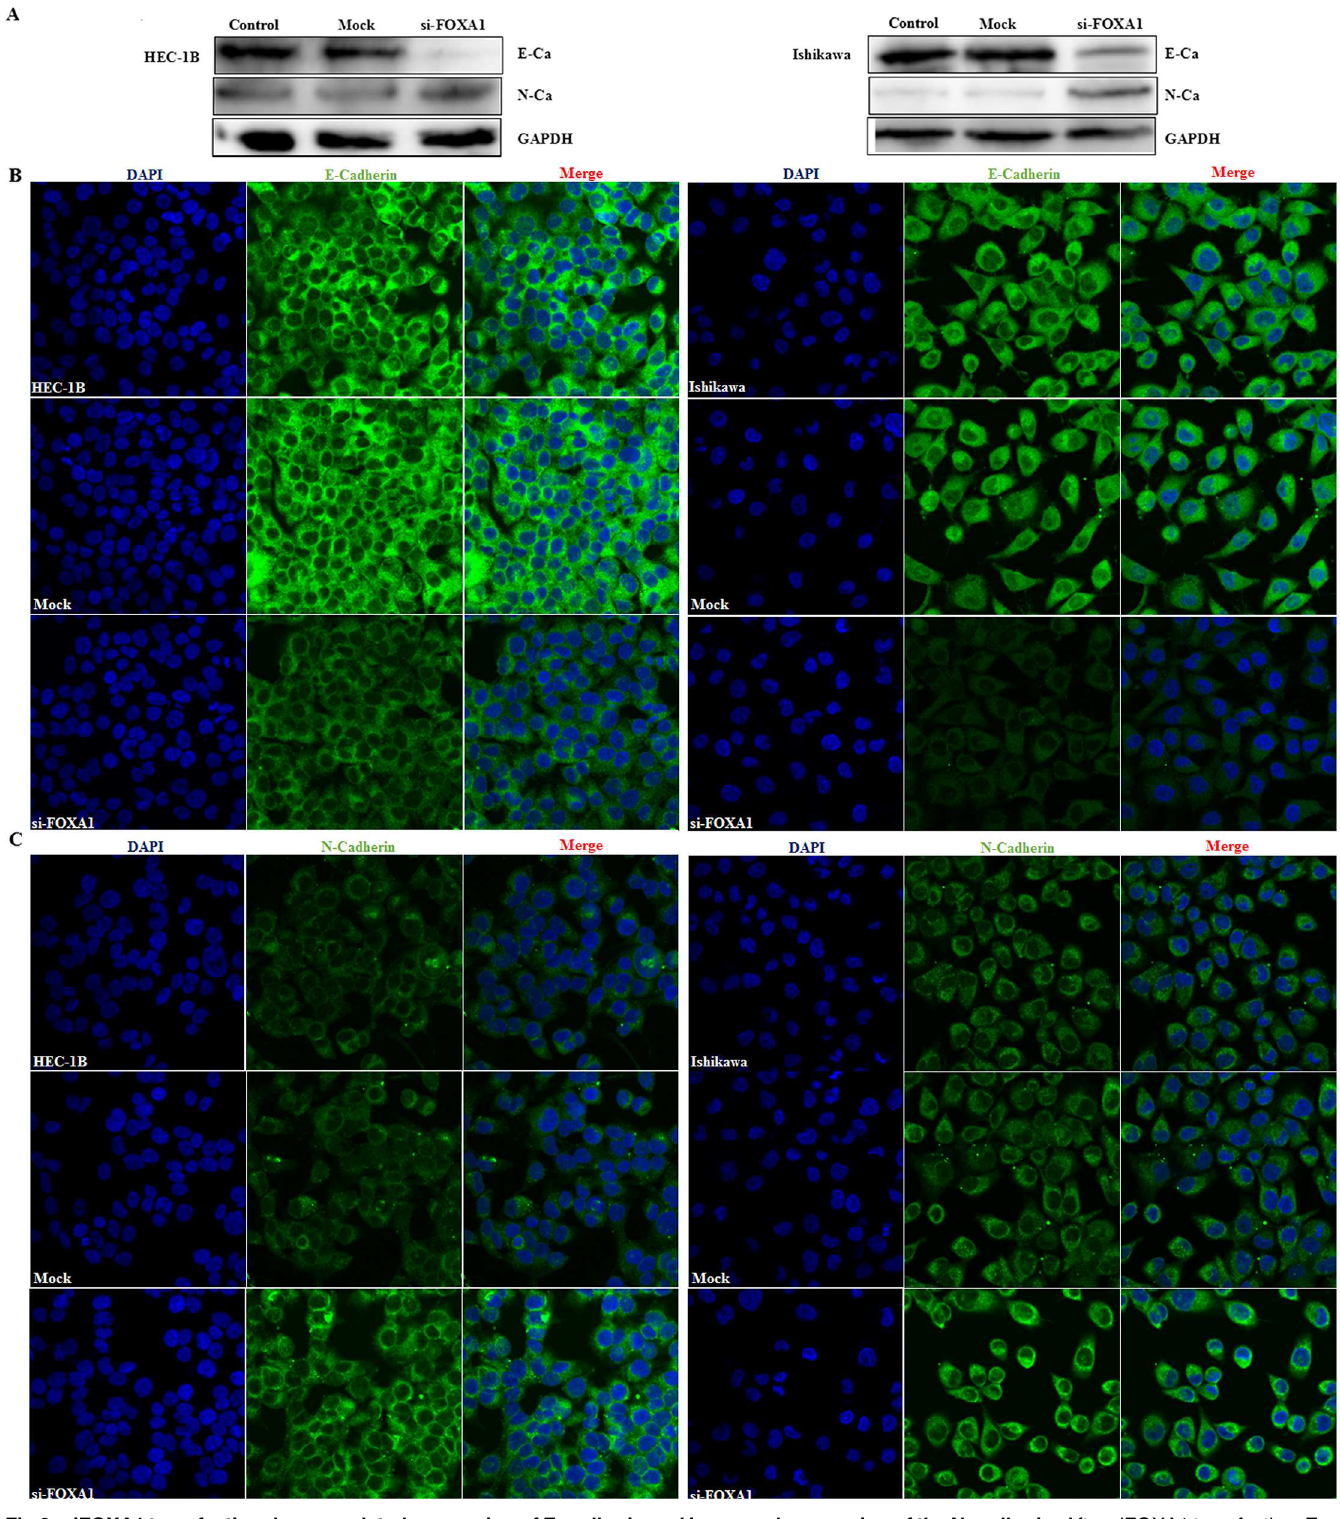
Fig 6. siFOXA1 transfection downregulated expression of E-cadherin and increased expression of the N-cadherin. After siFOXA1 transfection, E- cadherinwas downregulated and N-cadherin was upregulatedin Western blot assay (A). Besides, Immunofluorescence assay was used to determine subcellular localizationof E-cadherinand N- cadherin(B & C).